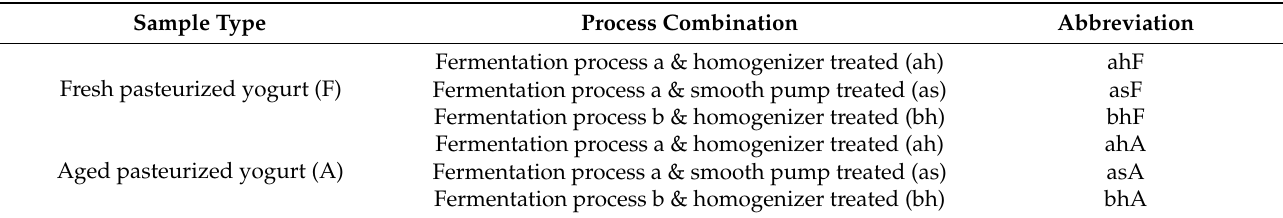
Table 4. Detailed information of six pasteurized yogurt